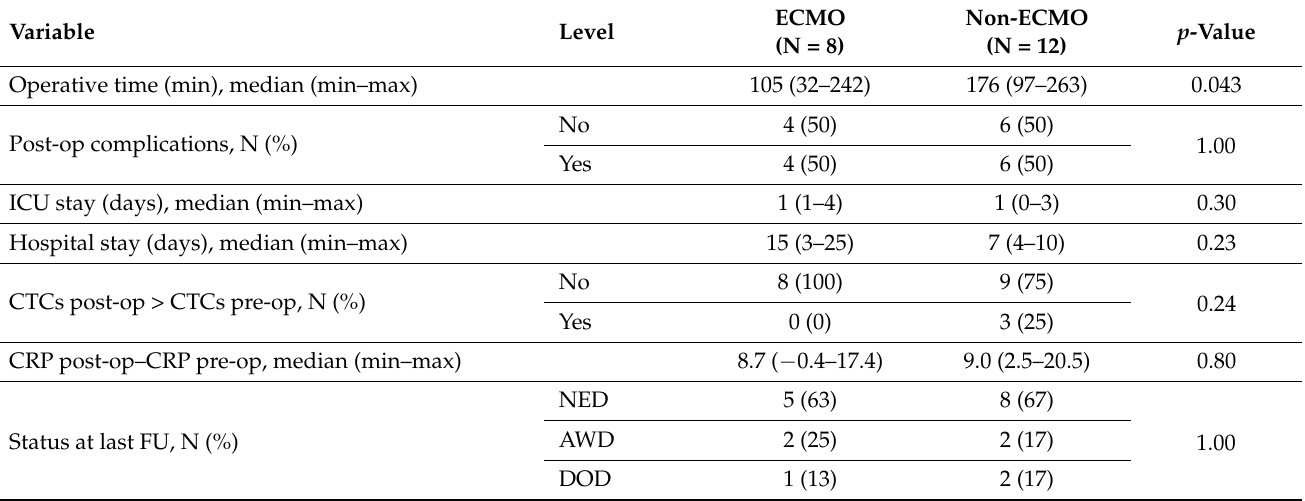
Table 3. Distribution of outcome variables among patients with and without intraoperative ECMO (N =